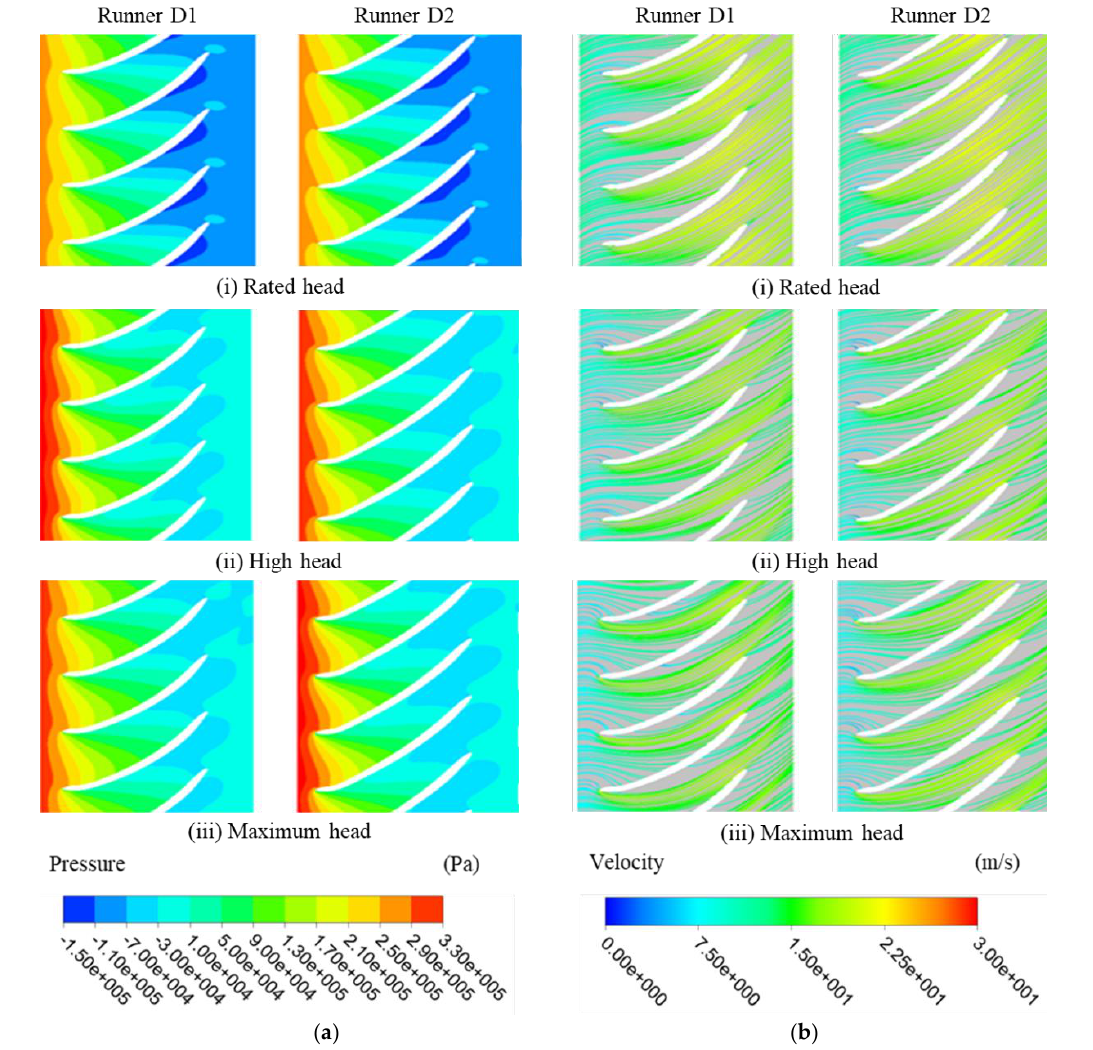
Figure 16. Flow conditions on the middle span surface of runners D1 and D2. ( a ) Pressure contours; ( b ) Surface streamlines.